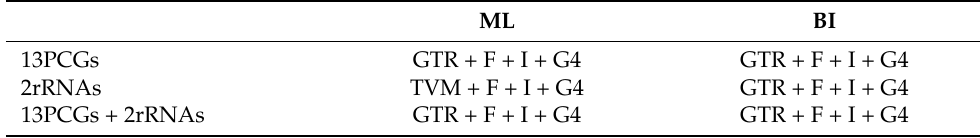
Table 4. Best-fit models of three datasets used for